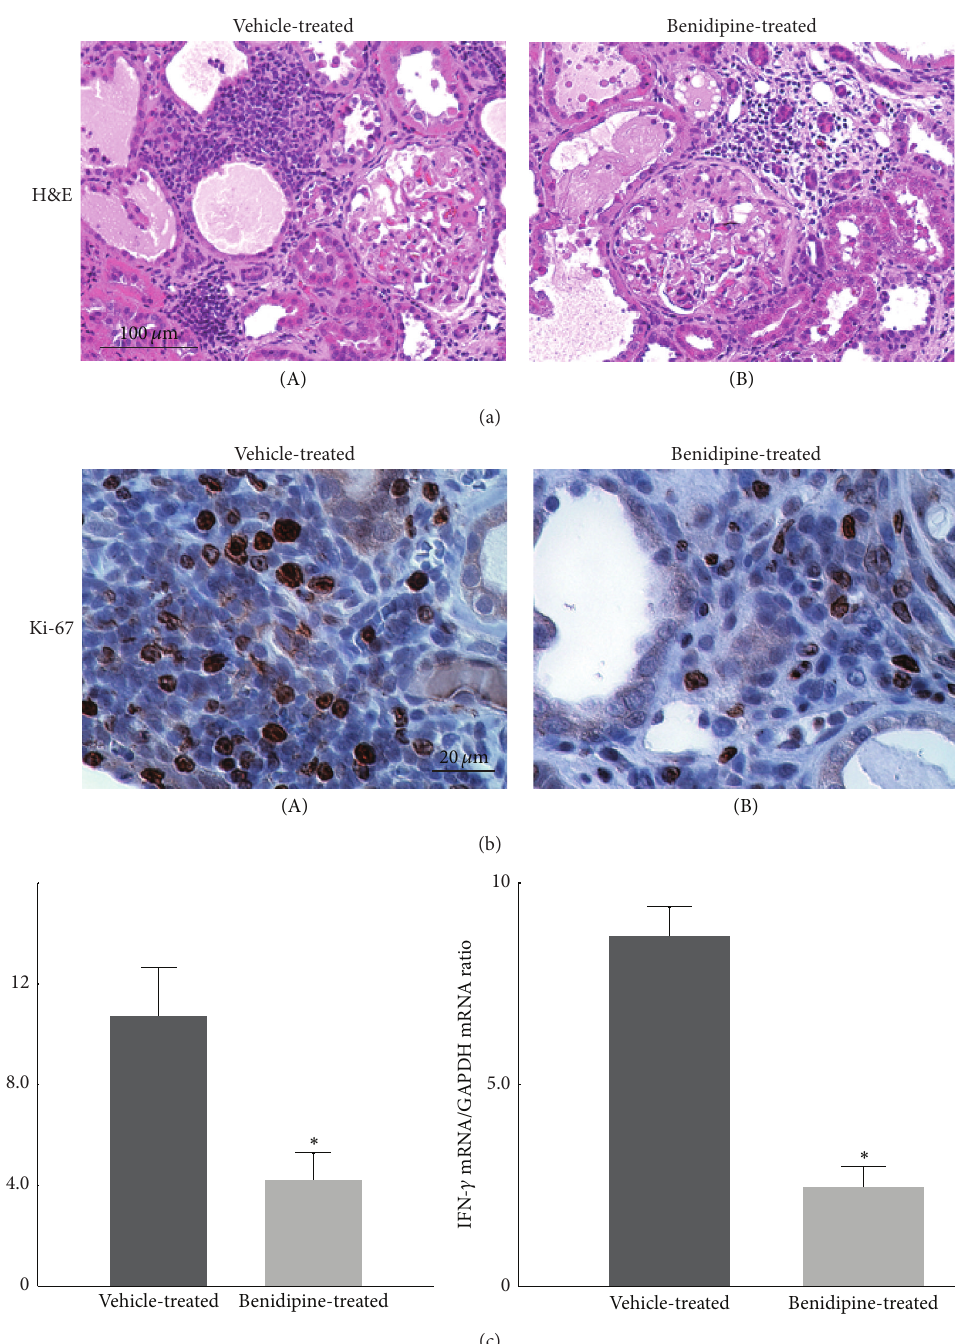
Figure 4: Histological features of vehicle- and benidipine-treated CRF rat kidneys and the expression of proinflammatory cytokines. (a) Hematoxylin and eosin staining (H&E) in vehicle-treated and benidipine-treated CRF rat kidneys. Low-power views of the cortex. Magnification, × 20. (b) Immunohistochemistry using antibody for Ki-67 (brown) in vehicle- and benidipine-treated CRF rat kidneys. High- power views of the cortical interstitium. Magnification, × 60. (c) The abundance of IL-2 mRNA (left) and interferon- 𝛾 (IFN- 𝛾 ) (right) in the renal cortex of vehicle-treated and benidipine-treated CRF rat kidneys. ∗ 𝑃 < 0.05 versus vehicle-treated CRF rats. Values are means ± SEM ( 𝑛 = 5 ). Differences were analyzed by ANOVA followed by Dunnett’s or Student’s 𝑡 -test. Modified from